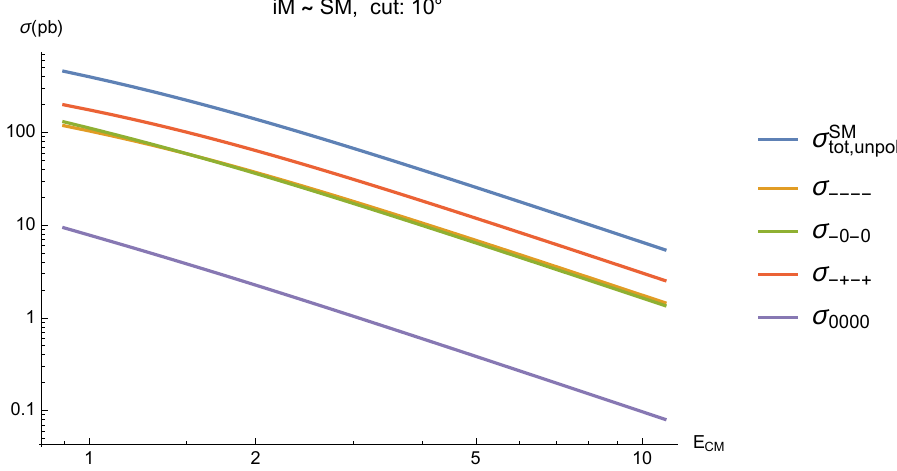
Figure 7 . Contributions of different polarisations (multiplicity taken into account) to the total unpolarised cross section as functions of the c.o.m. WW energy ( E SM. The total unpolarised cross section is also shown in